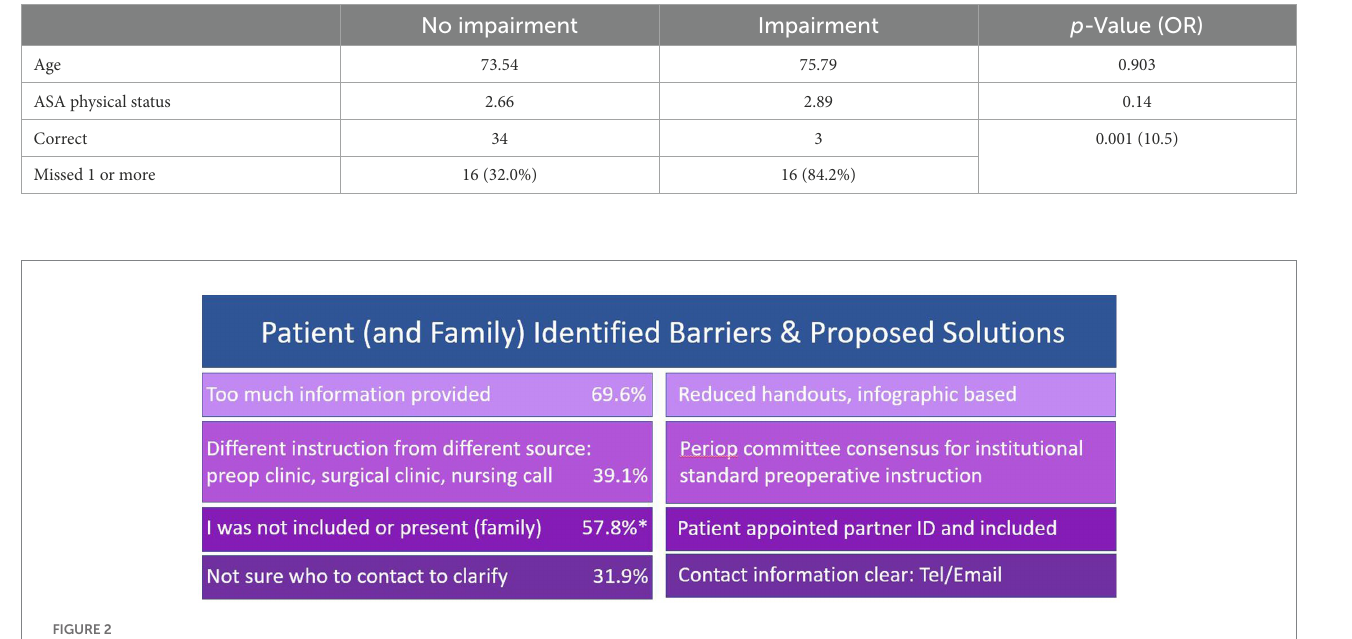
TABLE 1 Preoperative instruction compliance among patients with and without cognitive impairment or frailty (baseline).